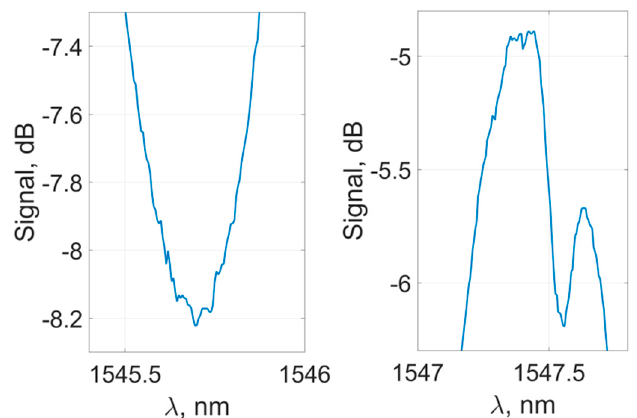
Figure 5. Shape of the sensor’s spectral peaks and features preventing the accurate determination of their characteristics.